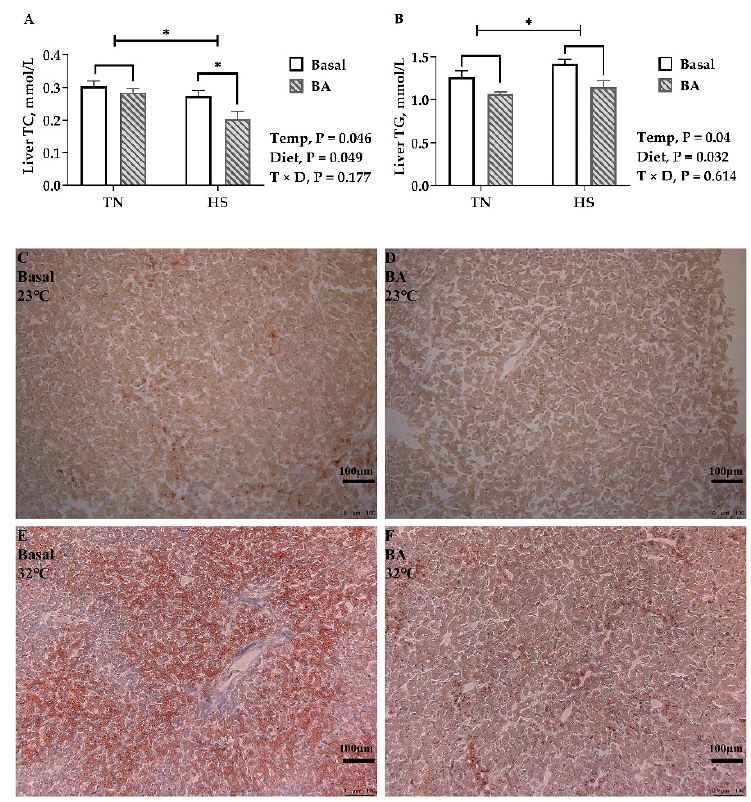
Figure 5. Lipid deposition in the liver of broilers fed with 0 or 200 mg/kg bile acids under ther- moneutral (TN) and heat-stressed (HS) conditions. ( A ) TC, total cholesterol; ( B ) TG, triglycerides; ( C – F ) Representative images of Oil Red O staining (100×). Data are the means ± SEM (n = 6 for each group). * p < 0.05.